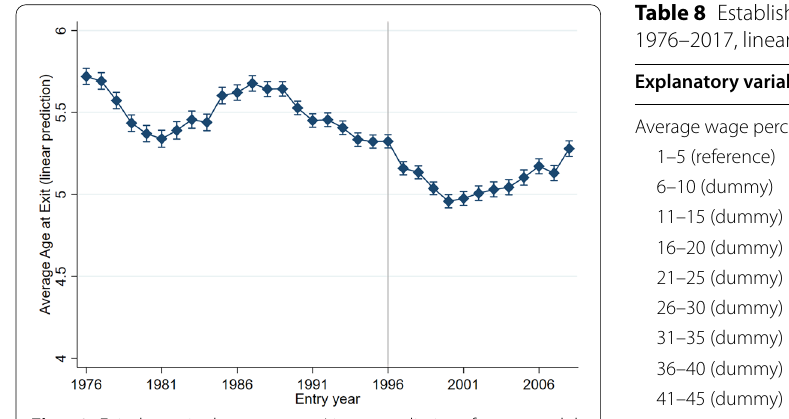
Fig. 19 Exit dynamics by entry year. Linear predictions from a model without control variables